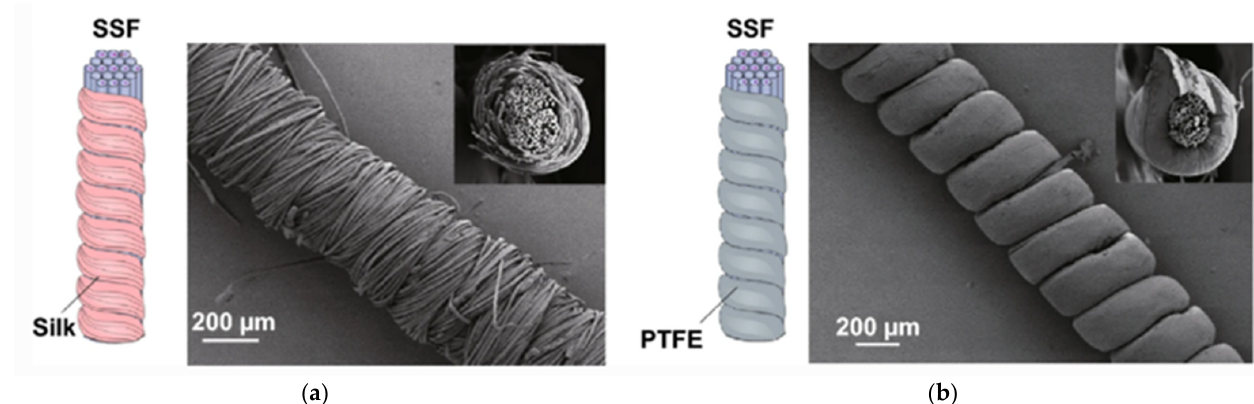
Figure 7. Example of recent developments toward triboelectric energy harvesting materials and structures for textile application: core-spun yarns composed of silk ( a ) and PTFE ( b ) fibers wrapped around a stainless steel fiber (SSF) core (reproduced from [104], available through the Creative Commons license (creativecommons.org/licenses/by/4.0/).